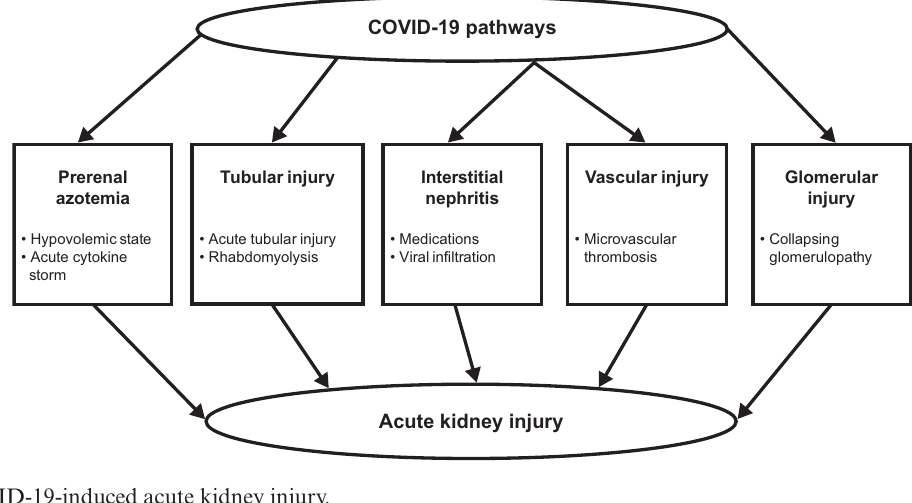
Figure 1. COVID-19-induced acute kidney injury.